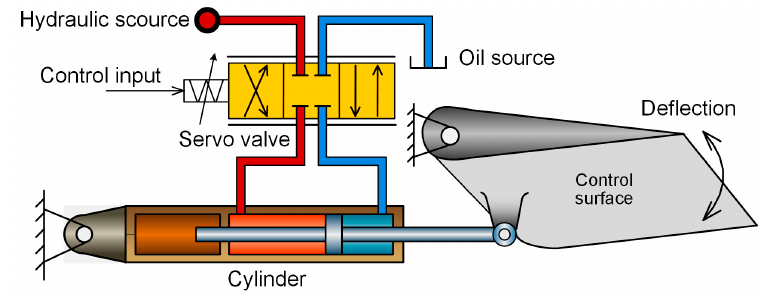
Figure 1. The typical structure of the HA system.